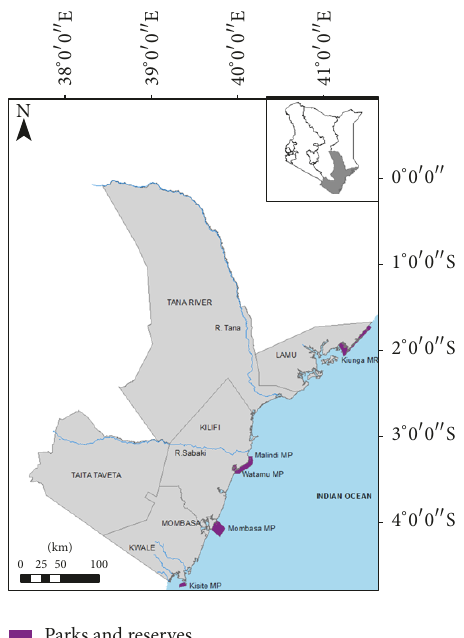
Figure 1: Map of the Kenyan coast showing the four studied marine protected areas (MPAs): Malindi, Watamu, Mombasa, and Shimoni